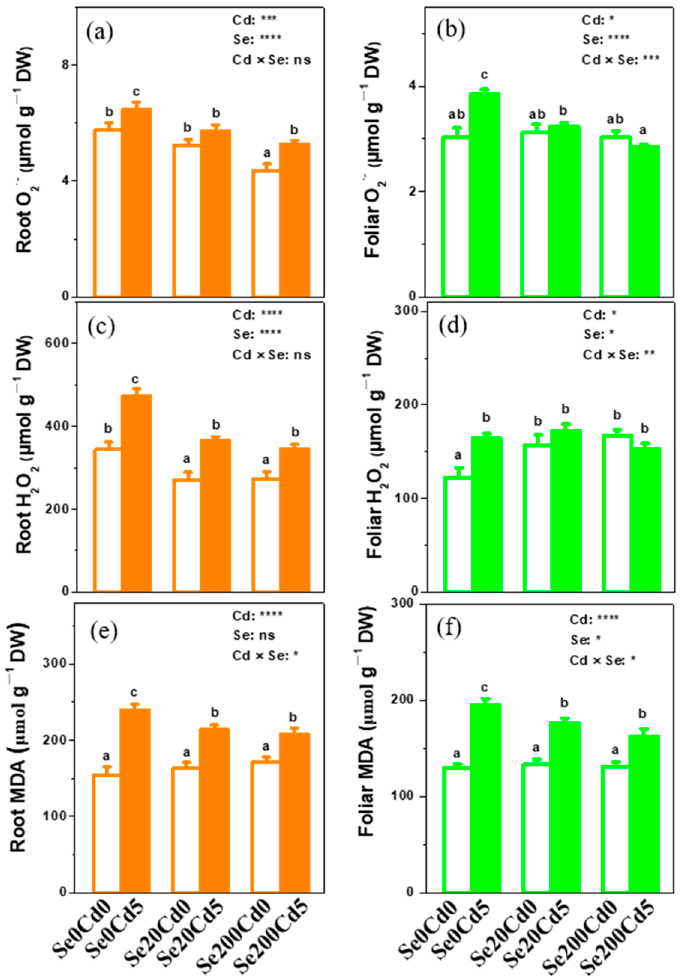
Figure 2. The contents of O 2 •− ( a , b ), H 2 O 2 ( c , d ), and MDA ( e , f ) in the roots and leaves of J. regia (variety Xinfeng) exposed to either 0 (Cd0) or 5 mM (Cd5) Cd together with one of three Se levels (0 (Se0), 20 (Se20) or 200 (Se200) µ M Se). Data were means ± SE (n = 6). Different lowercase letters on the bars indicate significant difference at p < 0.05 (F-test). p -values of the ANOVAs for Cd, Se and their interaction (Cd × Se) are also indicated. *, p < 0.05; **, p < 0.01; ***, p < 0.001; ****, p < 0.0001; and ns, insignificant.